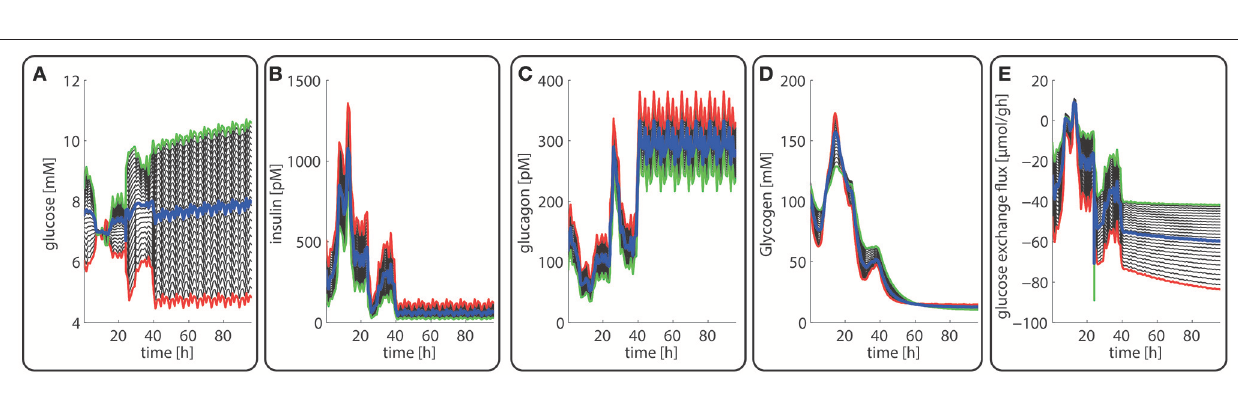
FIGURE 7 | Diurnal variations in the plasma levels of glucose (A) , insulin (B) , glucagon (C) , cellular glycogen (D) and the glucose exchange flux (E) in different zones along the porto-central axis during the transition from a well-fed state ( t = 0–24h) to a fasted state ( t > 24h) of the rate. The different curves refer to different spatial positions of hepatocytes, counted from periportal (red curve) to percentral (green curve). The bold blue line refers to the means values of the shown variables. Note that the red curves ( = most portal cell) for the hormones and glucose are identical with their plasma